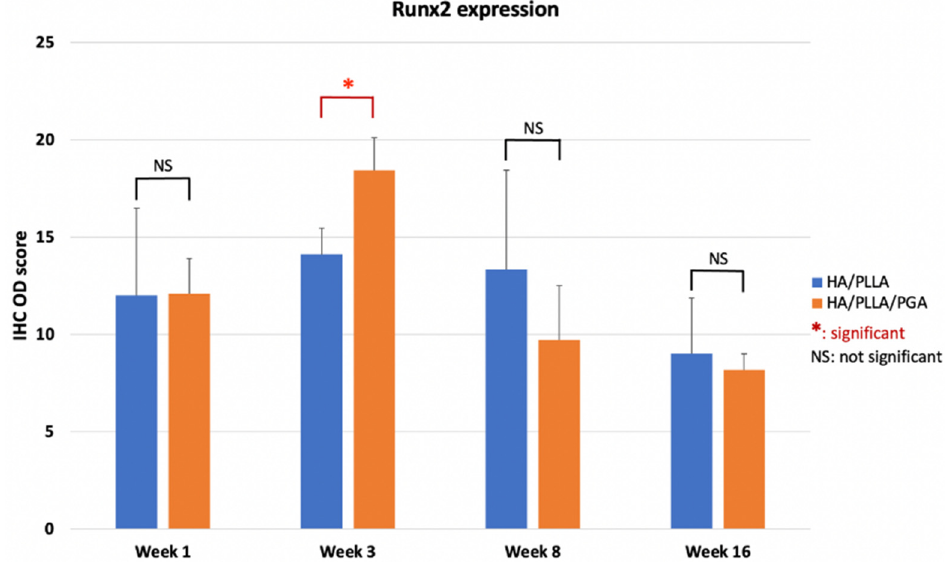
Figure 11. IHC OD score of Runx2 in the u-HA/PLLA and u-HA/PLLA/PGA groups. * p < 0.05.